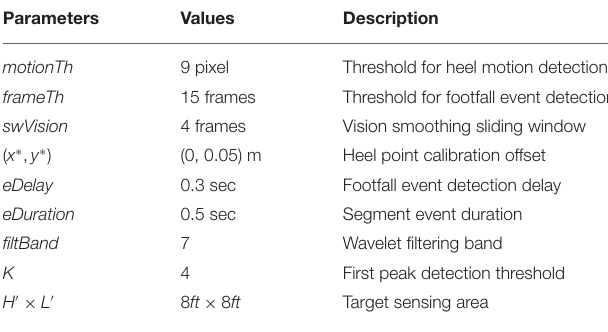
TABLE 1 | AutoLoc implementation